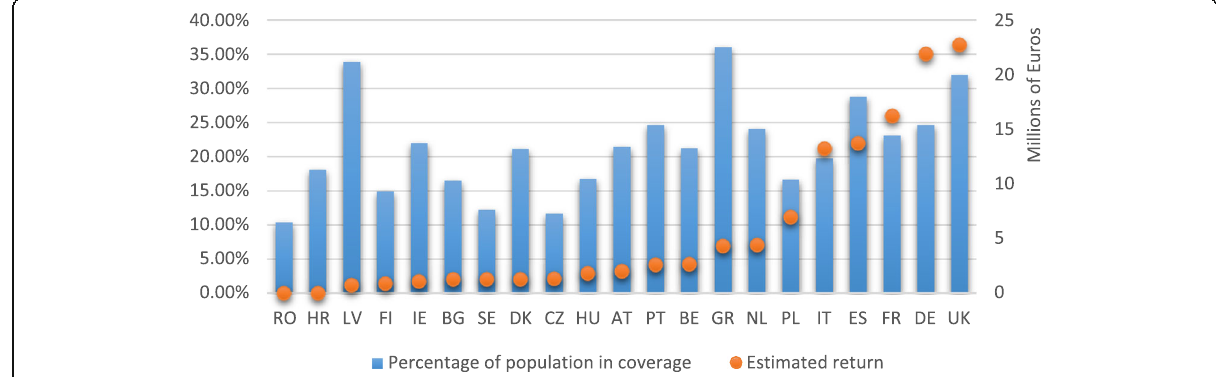
Fig. 15 Percentage of population covered by drone service (left axis) and estimated return of drone delivery hives per country (right axis) for Scenario 3 and a 650,000-euro economic viability threshold